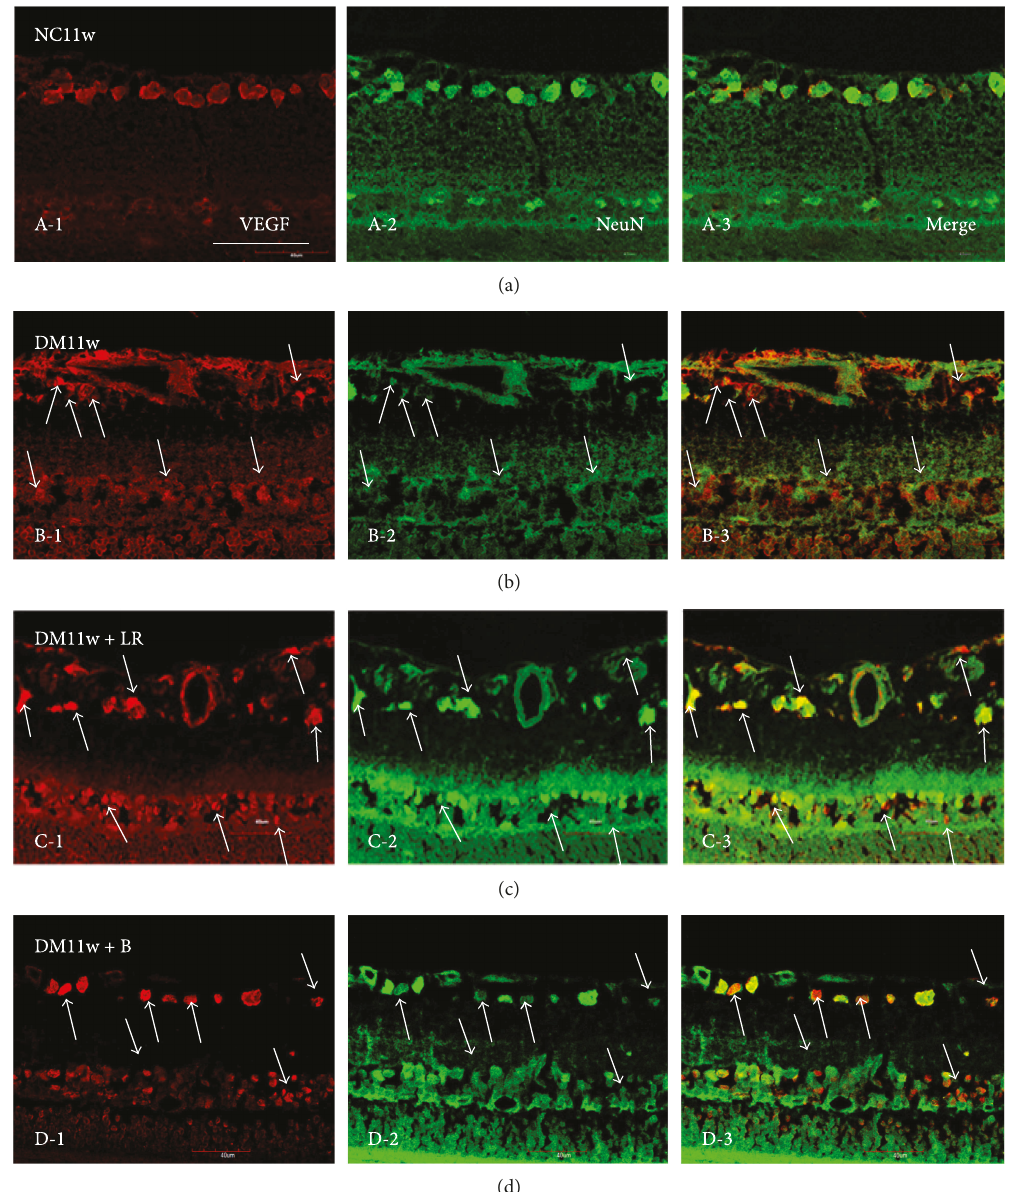
Figure 7: Representative photomicrographs of VEGF (red) and NeuN (green) double staining of the retina in the NC11w, DM11w, DM11w+LR, and DM11w+B groups. VEGF immunoreactivity was localized in NeuN-labeled neurons (single arrow) and blood vessels (asterisk). (a, b, c, D-1) The expression of VEGF was notably enhanced in the DM11w and DM11w+LR groups compared with the NC11w and DM11w+B groups. (a, b, c, D-2) Moreover, NeuN-labeled neurons appeared to be condensed and exhibit morphological changes in the DM11w and DM11w+ LR groups, in comparison with the NC11w and DM11w+ B groups. Bar =50 μ